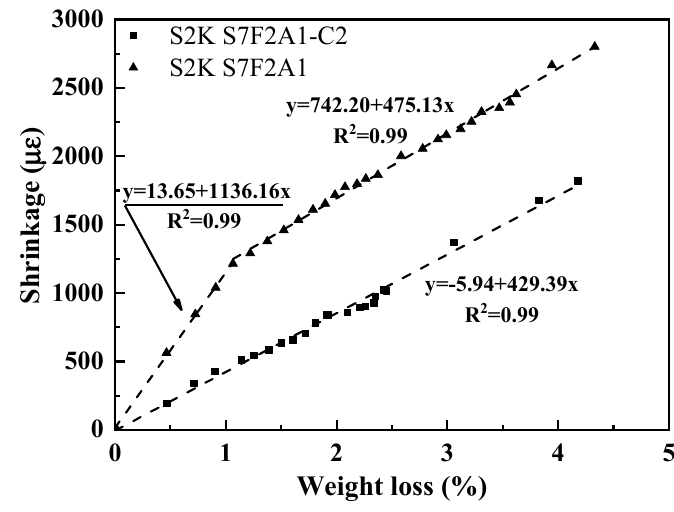
Figure 11. Mortars’ drying shrinkage vs. weight loss.